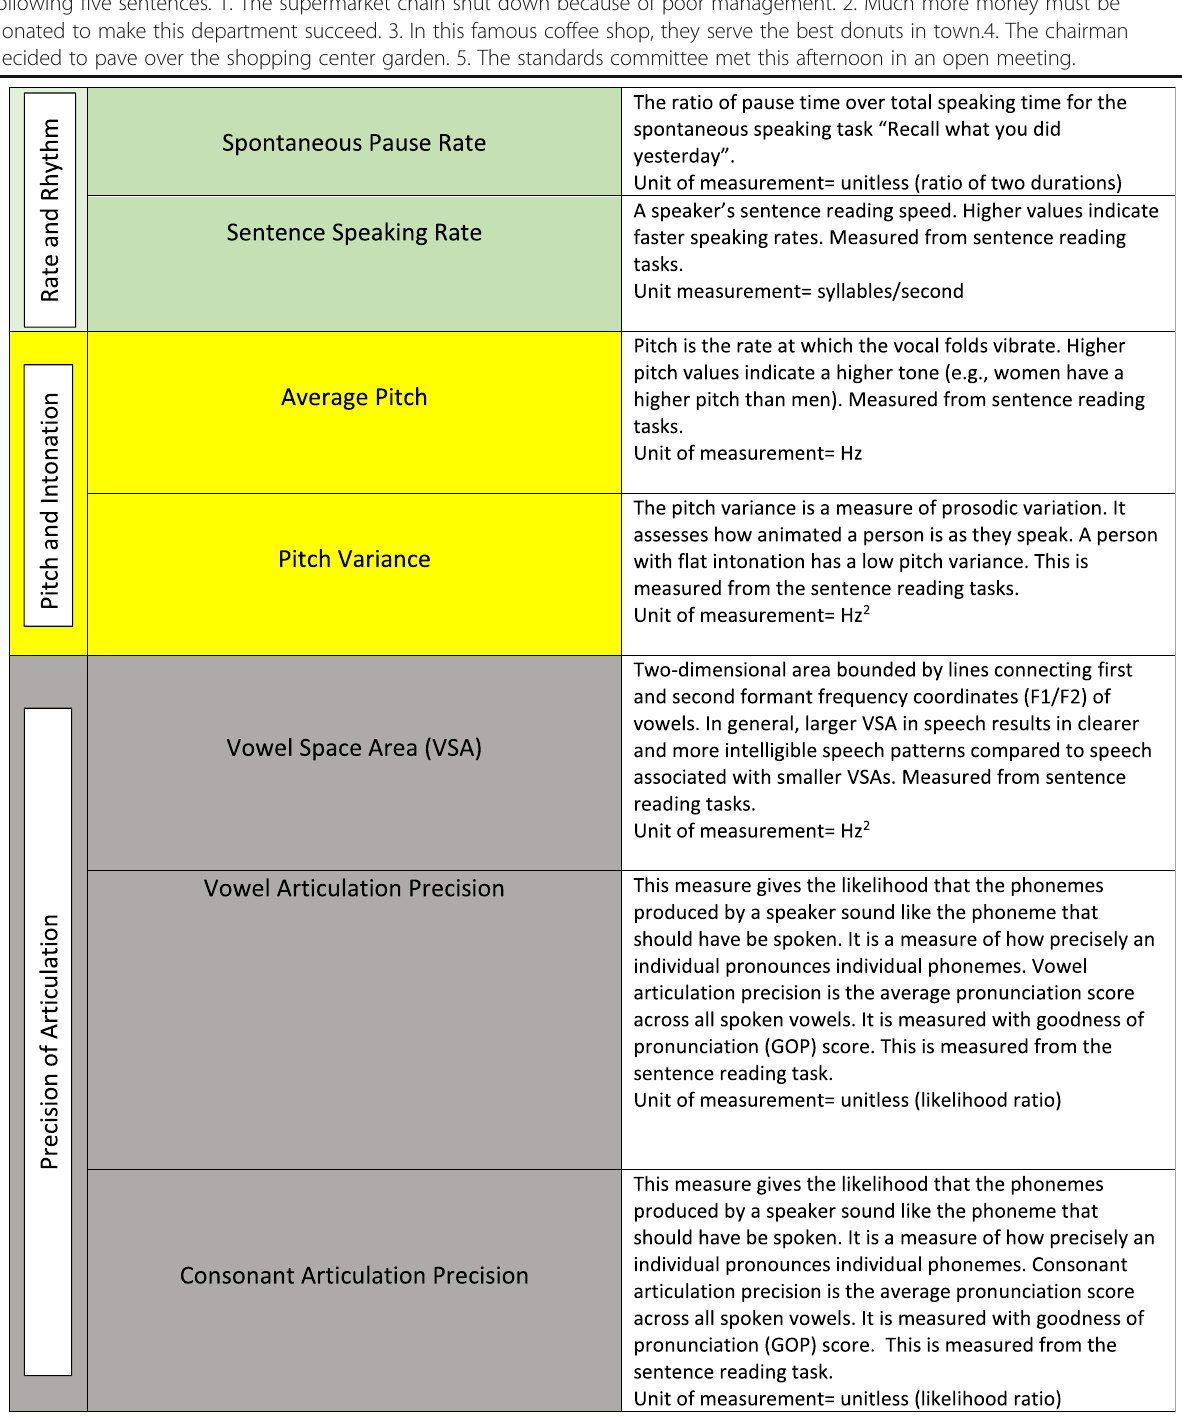
Table 1 Description of speech features that were extracted from the speech application. The calculations for the sentence speaking rate, average pitch, pitch variance, vowel space area, vowel and consonant articulation precision were extracted from reading